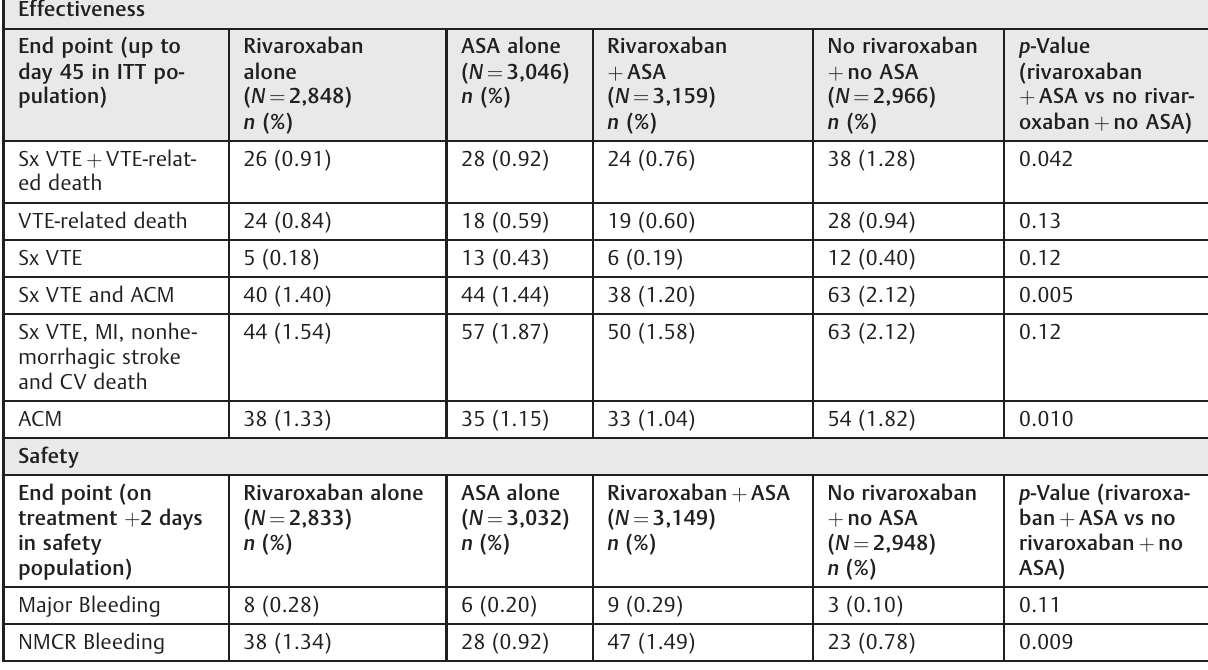
Table 2 Effectiveness and safety ed points in MARINER by treatment group